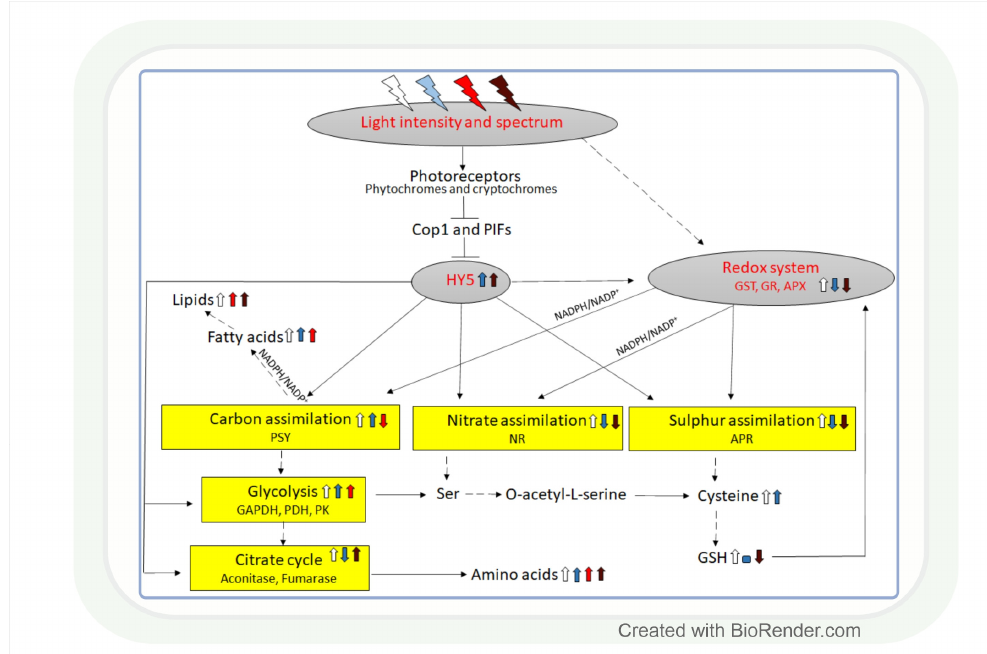
Figure 5. Light intensity- and spectrum-associated coordination of carbon, nitrate, and sulphate assimilation. The control of the three metabolic pathways is interconnected through the effect of light on the redox system and the HY5 transcription factor. The redox system regulates them through the NAD(P)H/NAD(P) + and GSH/GSSG redox couples and HY5 through its binding to the promoter of the genes related to these processes. White, blue, red, and dark red arrows indicate the effect of white, blue, red, and far-red light, respectively. Upwards arrows: induction, downwards arrows: repression, horizontal line: no effect. Continuous lines: direct connection, dashed lines: indirect connections with additional intermediates. APR: adenosine phosphosulphate reductase, APX: ascorbate peroxidase, Cop1: constitutive photomorphogenic1, GAPDH: glyceraldehyde phosphate dehydrogenase, GR: glutathione reductase, GST: glutathione S-transferase, NR: nitrate reductase, PDH: pyruvate dehydrogenase, PK: pyruvate kinase, PIF: phytochrome-interacting factor, PSY: phytoene synthase.